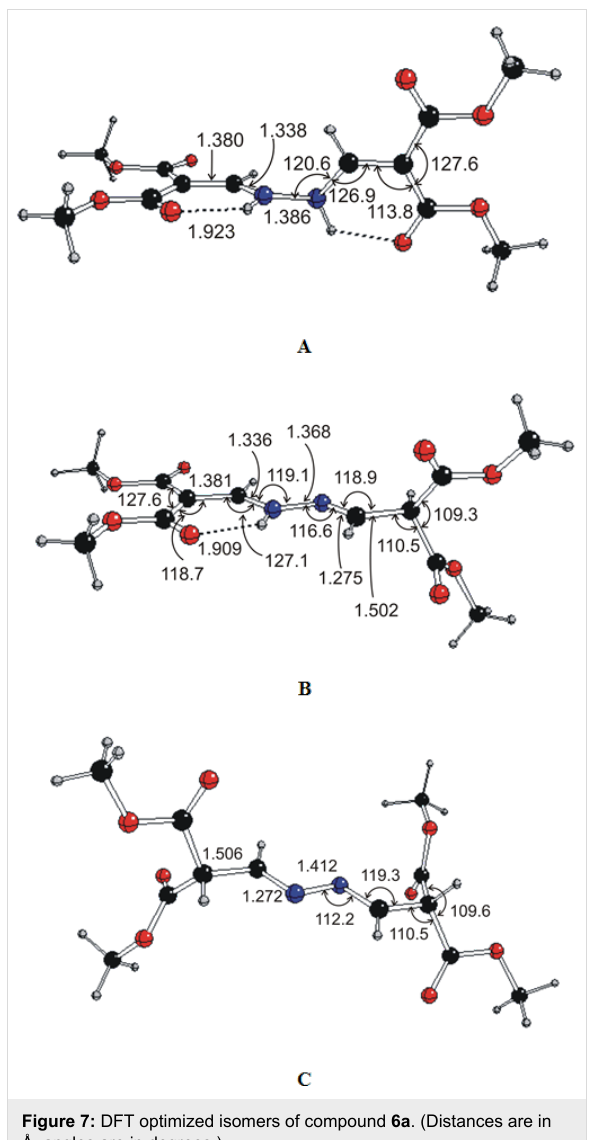
Figure 7: DFT optimized isomers of compound 6a . (Distances are in Å, angles are in